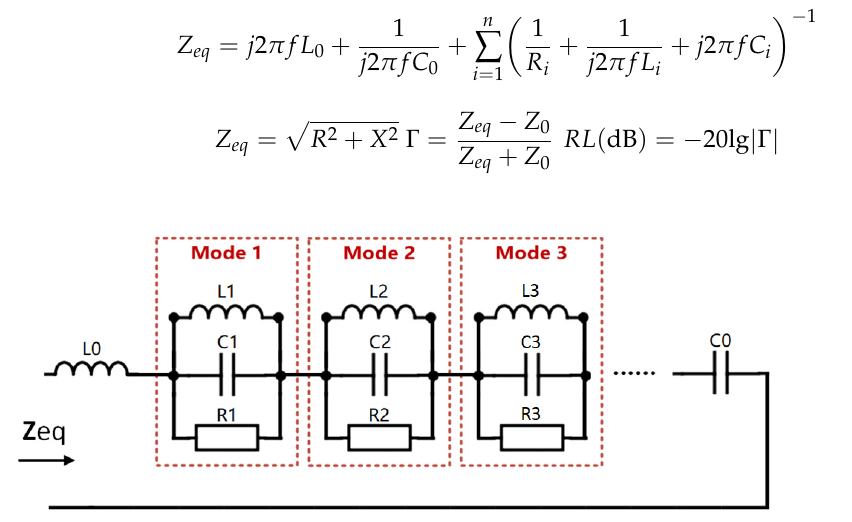
Figure 6. Equivalent circuit model of a single resonant mode antenna element.